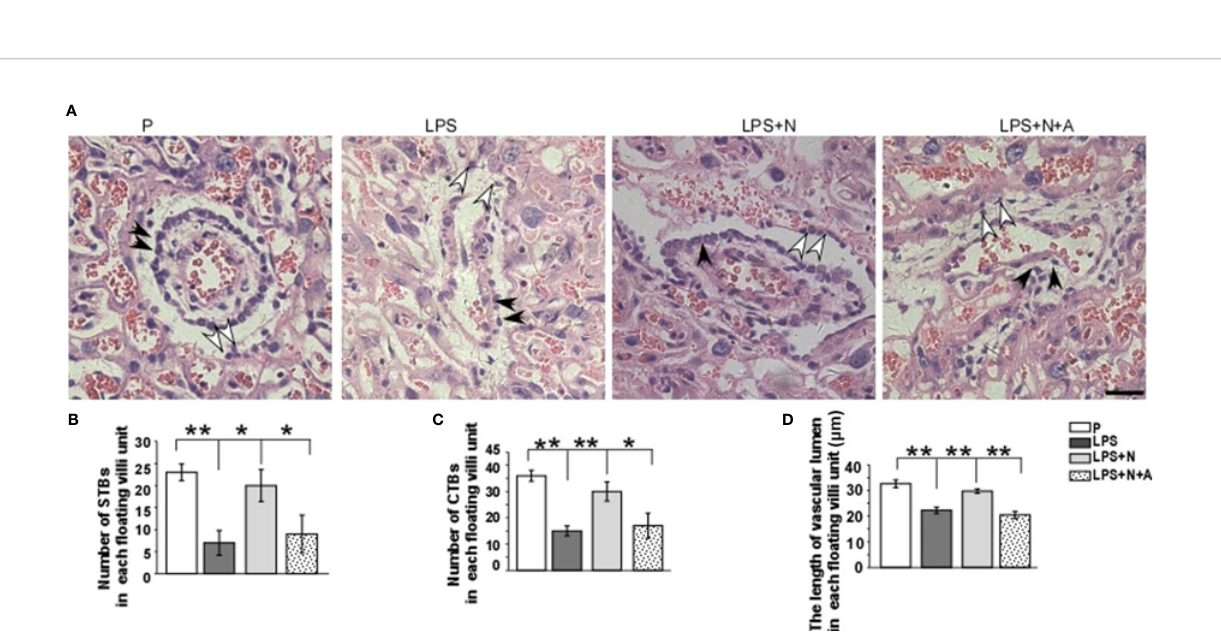
FIGURE 3 | H&E staining showed morphological changes of trophoblasts and vascular lumen in placentas from all experimental groups. (A) White arrows indicated syncytiotrophoblasts (STBs), black arrows indicated cytotrophoblasts (CTBs). The number of STBs and CTBs seemed decreased in LPS group, their shape seemed being deformed; vascular lumen also became narrow. The a 7nAChR agonist (nicotine) alleviated pathological changes of placenta to some extent. Histograms showed changes in the number of STBs (B) and CTBs (C) and the length of vascular lumen (D) in the placentas in all animal groups. Scale bar=30 m m. *P < 0.05 and **P < 0.01.